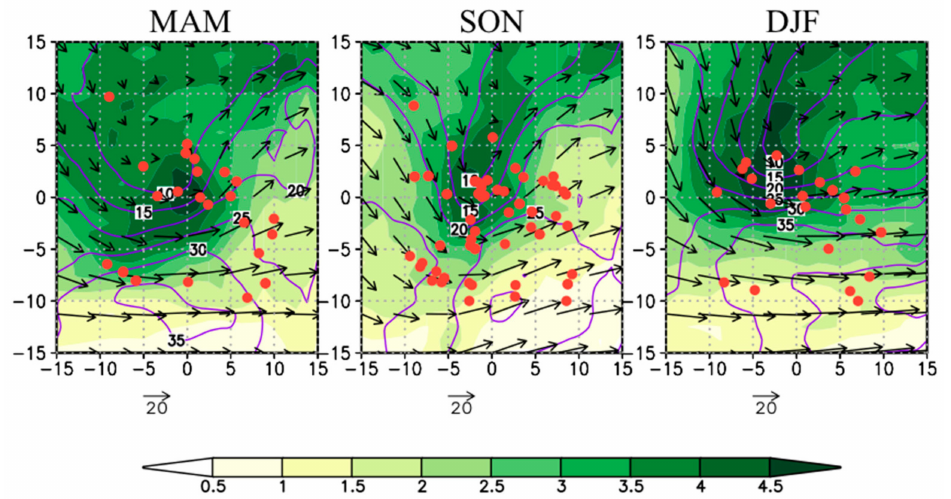
Figure 7. Cyclone relative composite: 250 hPa potential vorticity ( PV ) (colors; PVU), 250 hPa wind vectors (line; m s − 1 ). ( left ) spring, ( middle ) autumn, and ( right ) winter. Cyclone-relative tornado locations are shown with red